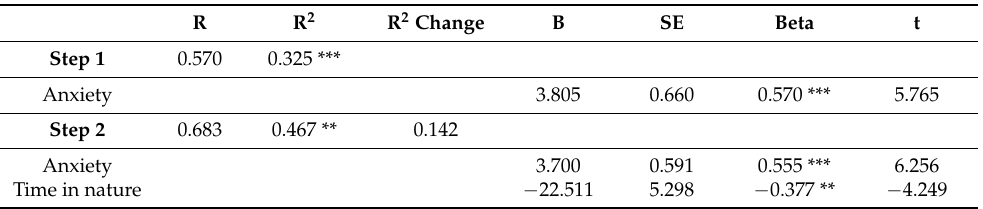
Table 5. Hierarchical multiple regression model of chronic fatigue. Time in nature is a significant predictor of chronic fatigue after controlling for anxiety.